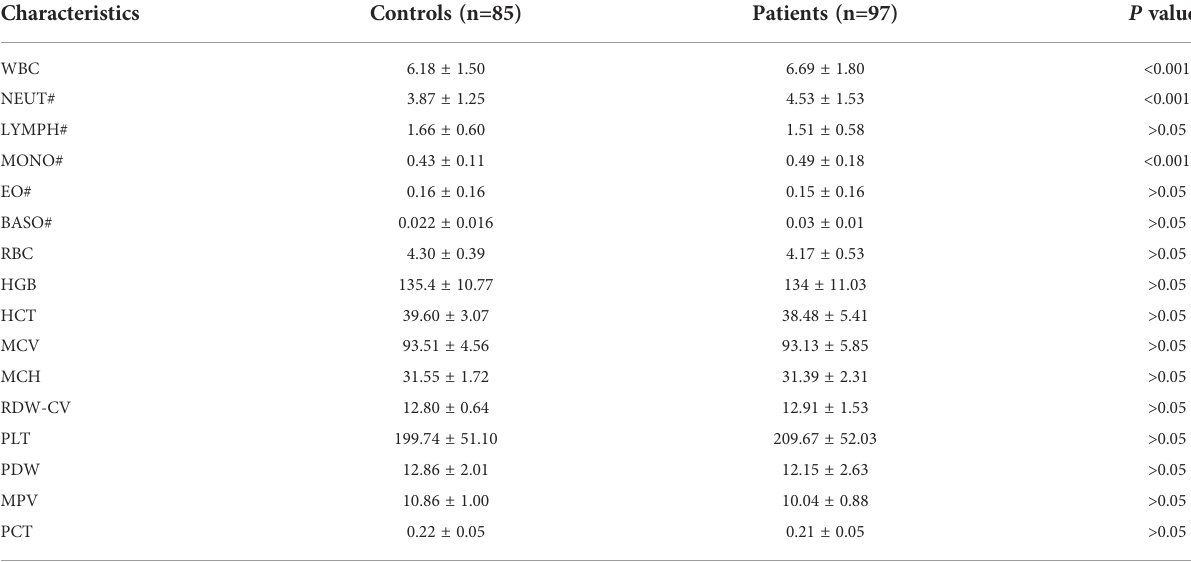
TABLE 2 Comparison of hematological indices between osteoporotic patients and healthy controls (only male). Characteristics